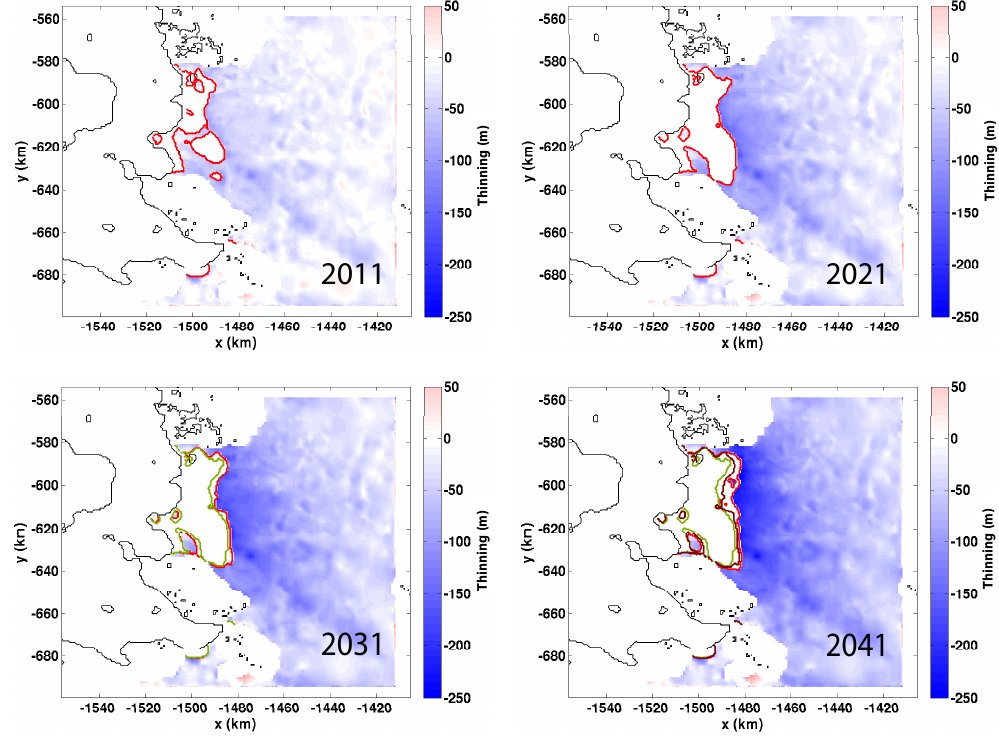
Figure 6. Cumulative thinning since 2001 (shading) and grounding-line position (red contours) in 40-year run from transient calibration. The 2021 and 2031 grounding lines are shown in successive plots with green and brown contours,